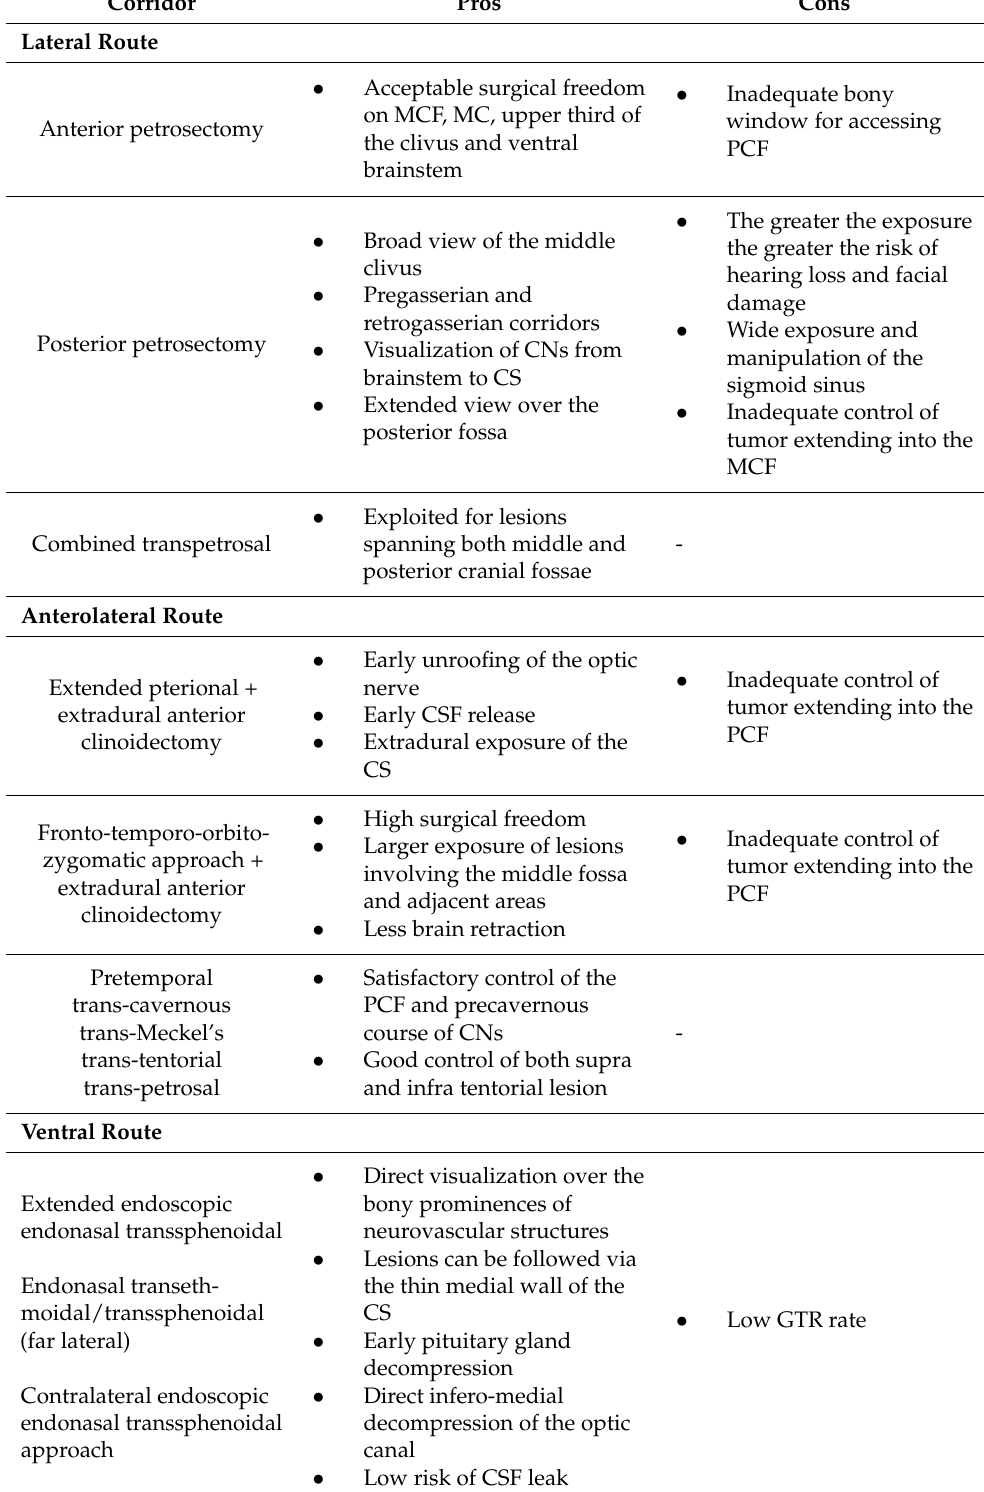
Table 5. Pros and cons for each corridor for the management of cavernous sinus meningiomas